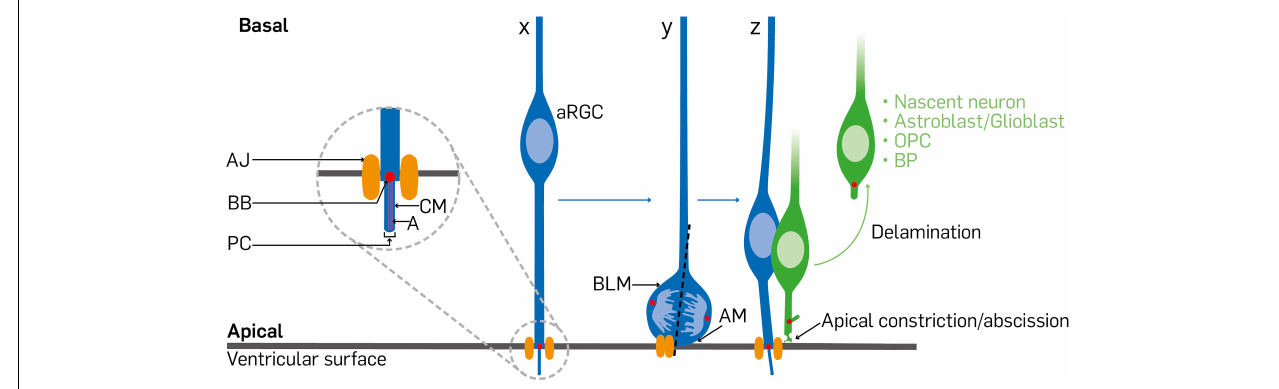
FIGURE 2 | Diagram depicting synopsis of cell delamination in the cortical neurepithelium. A typical radial glial cell (x) is anchored at its endfoot by an apical junction/adherens junction. When the radial glial cell receives signals to undergo differentiative/asymmetric division, its soma is positioned at the ventricular surface. The inheritance or distribution of components of the dividing radial glial cell (y) is a determinant of fate of the progenies. The primary cilium and associated mother centrosome, apical membrane, and adherens junction are distributed among the daughter cells such that the one to maintain the radial glia identity bears the primary cilium and associated basal body, acquires most of the apical membrane, and reestablishes the adherens junction (z). The daughter cell poised to differentiate withdraws from the adherens junction belt via apical constriction or abscission at the ventricular surface as delaminated cell, which could end up as a basal progenitor cell, nascent neuron, or a glial cell/precursor that basally relocates in the cortical wall. aRGC, apical radial glial cell; AJ, adherens junction; BB, basal body; PC, primary cilium; CM, ciliary membrane; A, axoneme; BLM, basolateral membrane; AM, apical membrane; OPC, oligodendrocyte precursor cell; BP, basal